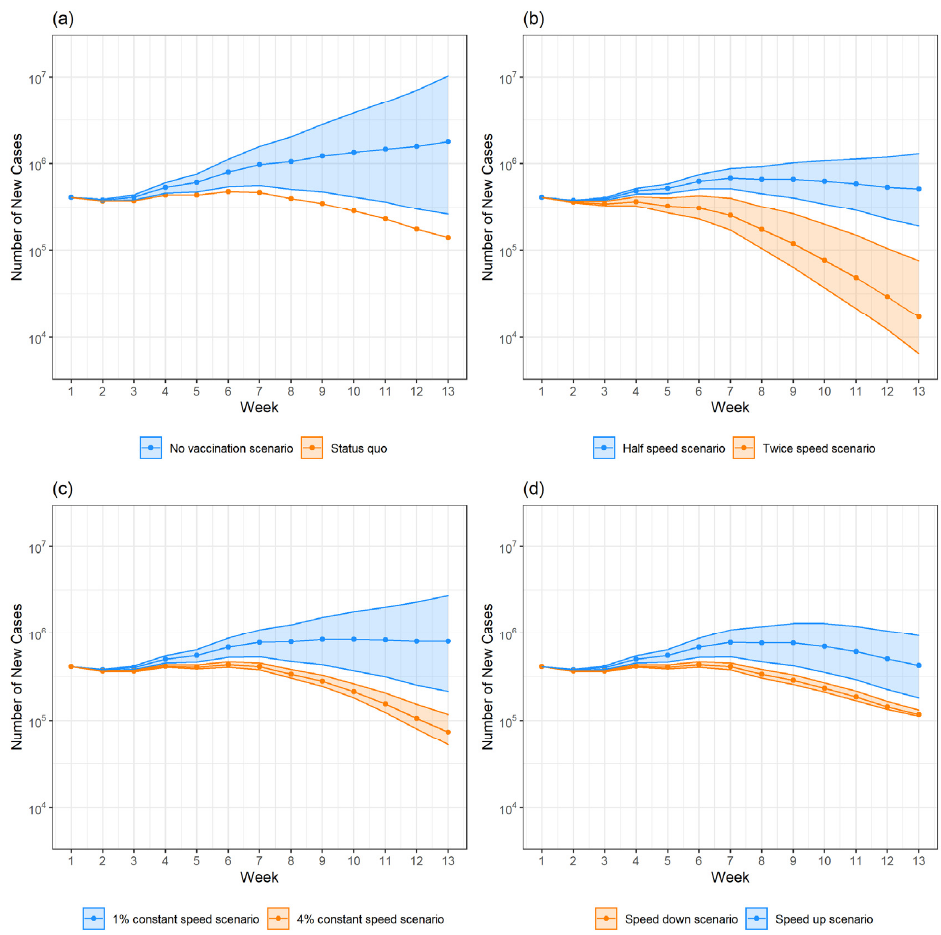
Figure 2. Predicted number of new cases in each week under different scenarios. Figure 2a shows the comparison of predicted number of new cases under no vaccination scenario and status quo. Figure 2b shows the comparison of predicted number of new cases under half speed scenario and twice speed scenario. Figure 2c shows the comparison of predicted number of new cases under 1% constant speed scenario and 4% constant speed scenario. Figure 2d shows the comparison of predicted number of new cases under speed up scenario and speed down scenario.